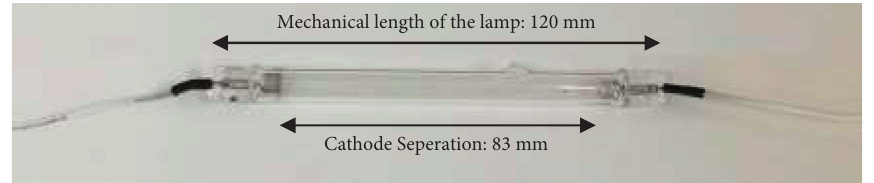
Figure 3: Custom-made cold cathode tube light. Table 1: Lamp irradiance measurements from different distances and power calculations based on Keitz formulation.